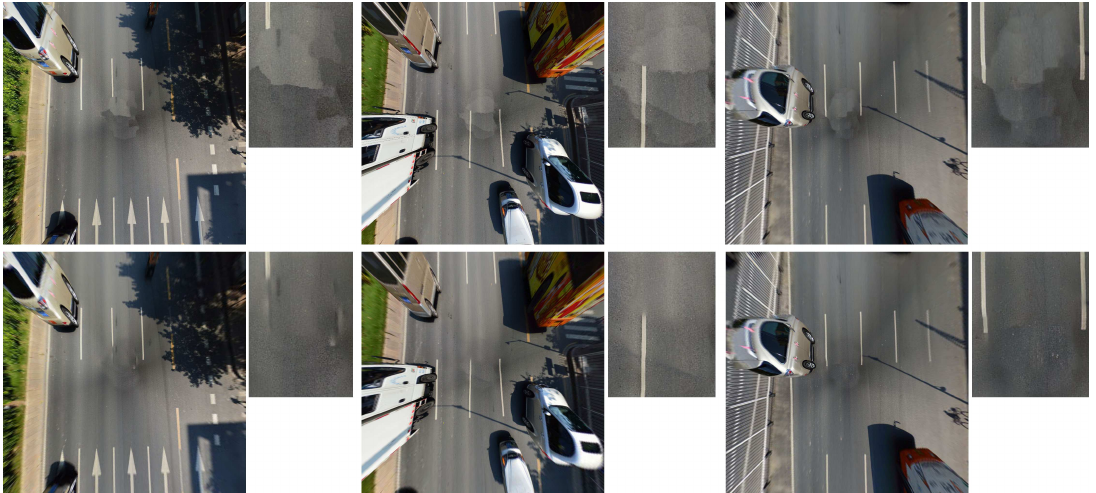
Figure 10. Comparative image completion results without applying a multi-band blending operation in the top row and with applying it in the bottom row.